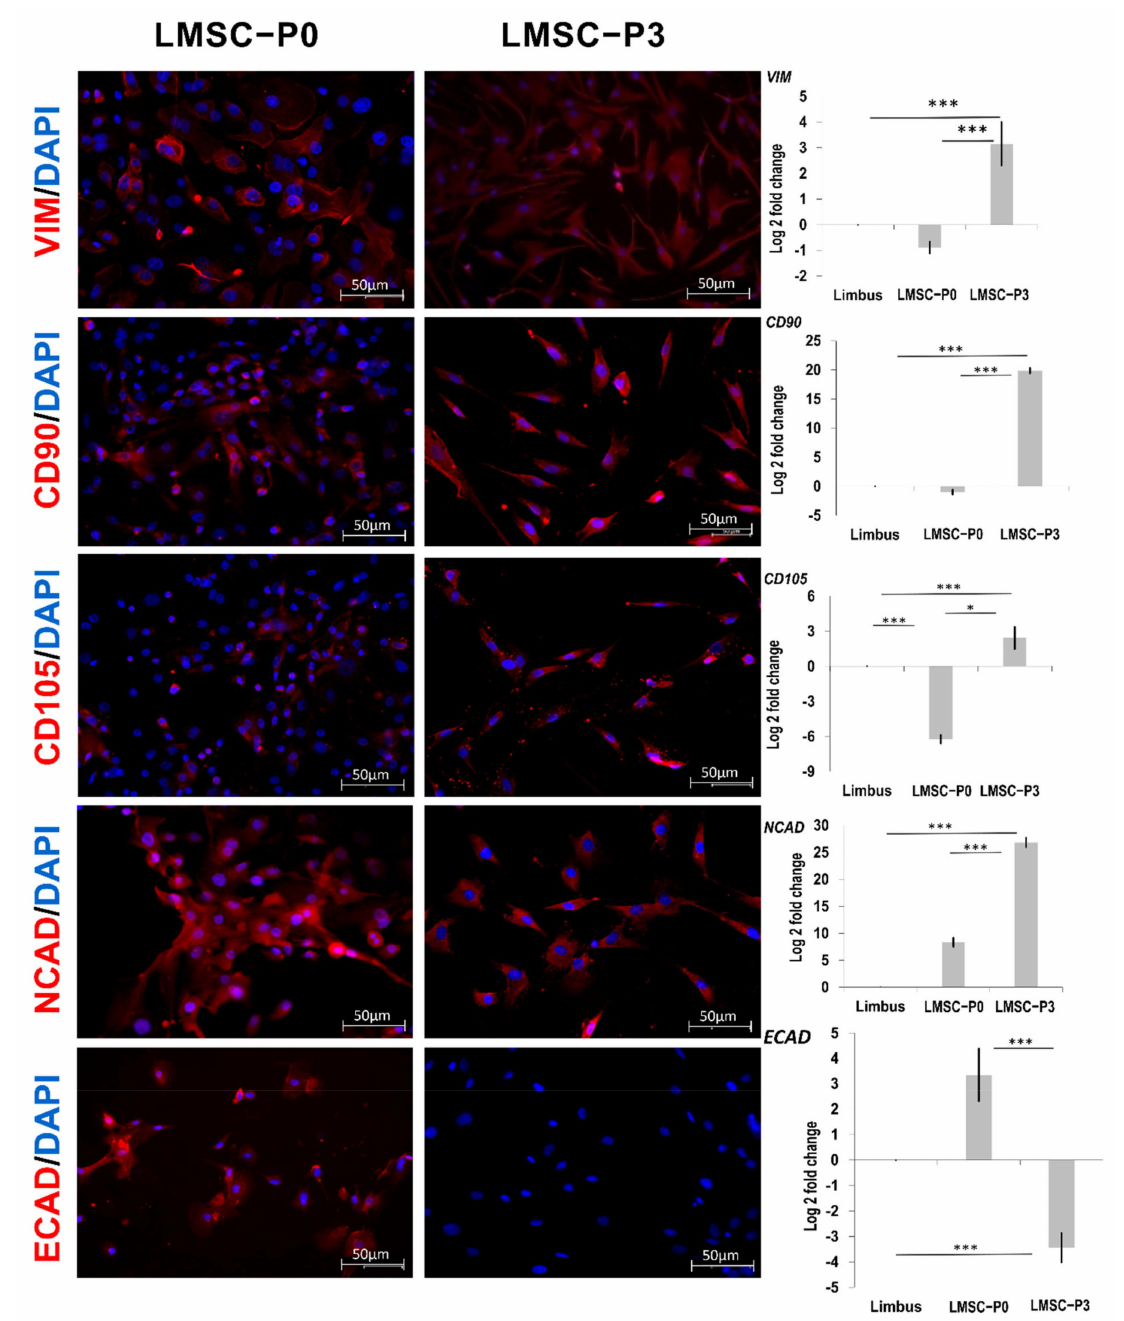
Figure 3. Limbal stem cells showing mesenchymal stem cell biomarkers. Panel of the representative images of the limbal stem cells showing positive expression of Vim (Vimentin), CD90, and CD105 in both LMSC − P0 ( n = 3) and LMSC − P3 ( n = 3) populations, counterstained with DAPI (blue). Ncad (N-cadherin) were positive (red) in LMSC − P3 cells and Ecad (E-cadherin) did not show any expression in LMSC − P3. Level of expression of VIM , CD90 , CD105 , NCAD , ECAD genes quantified using qRT-PCR in LMSC − P0 and LMSC − P3 relative to native limbal tissue ( n = 5). Except ECAD remaining genes were found to be up-regulated in LMSC − P3 with fold-change ranging between 2 to 20, which were down-regulated in LMSC − P0. Scale: 50 µ m. The results were plotted as mean log 2-fold change ± SD. The statistical analysis was performed using Kruskal–Wallis one-way ANOVA test. * p < 0.05, *** p <